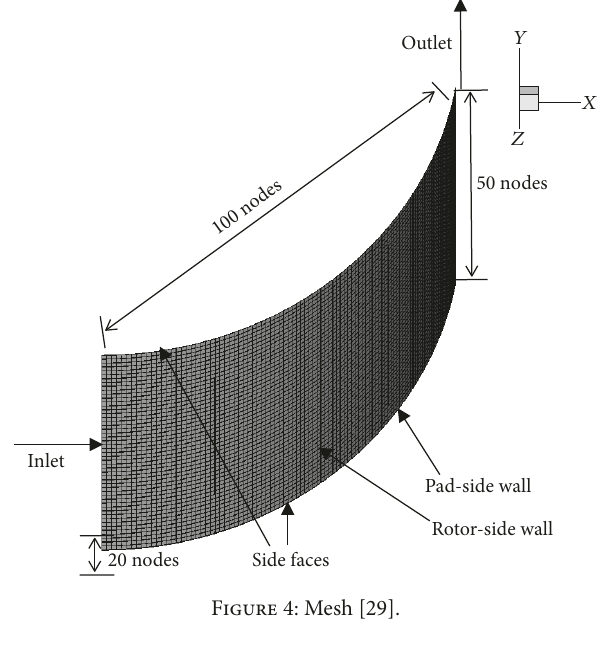
Figure 4: Mesh [29].